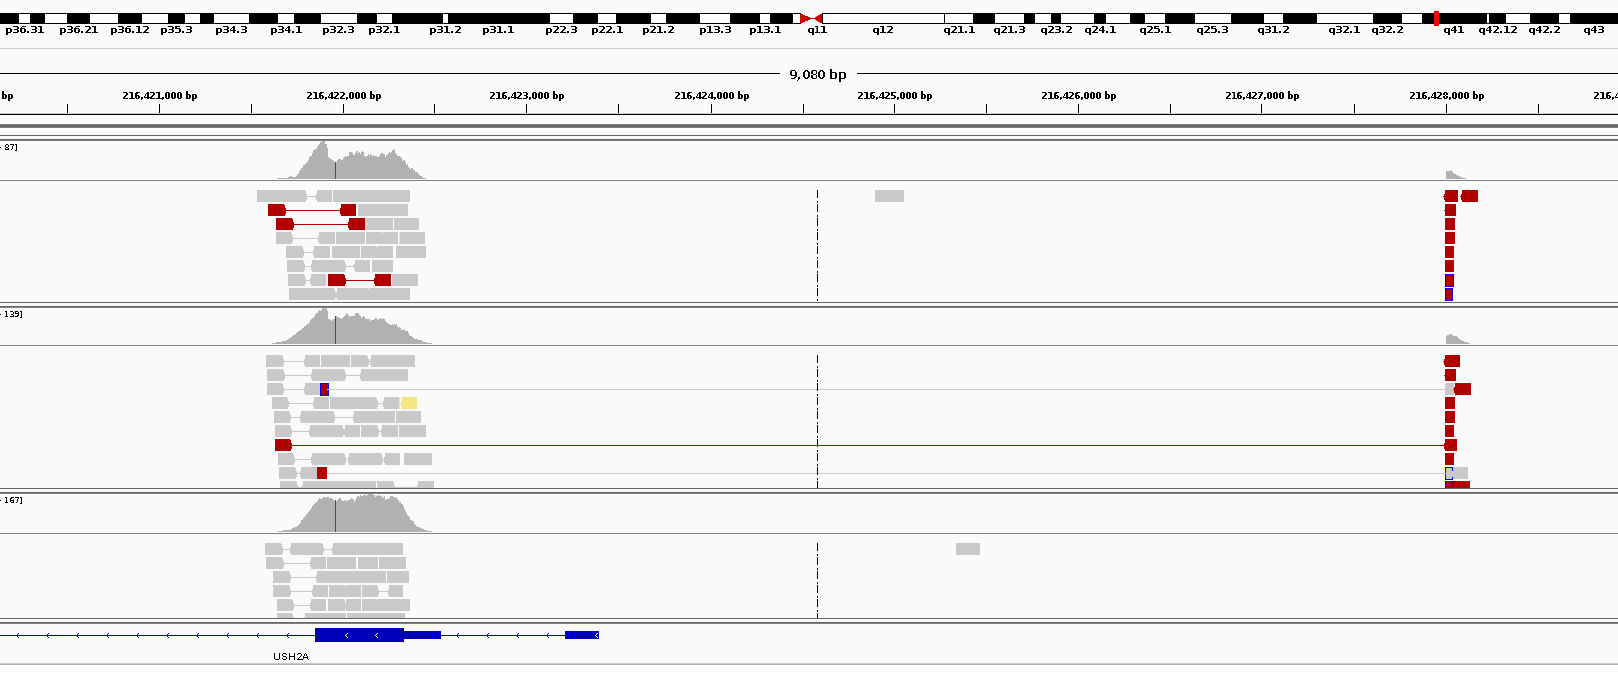
Figure 4. Sequence data from retinitis Pigmentosa (RP) patients with large USH2A deletions. The top two panels of reads are from the two affected patients who presented with RP. The bottom panel of reads is from an unaffected unrelated patient. Depicted above is the evidence of split reads (red) and a drop in read depth in the affected patients relative to a control.